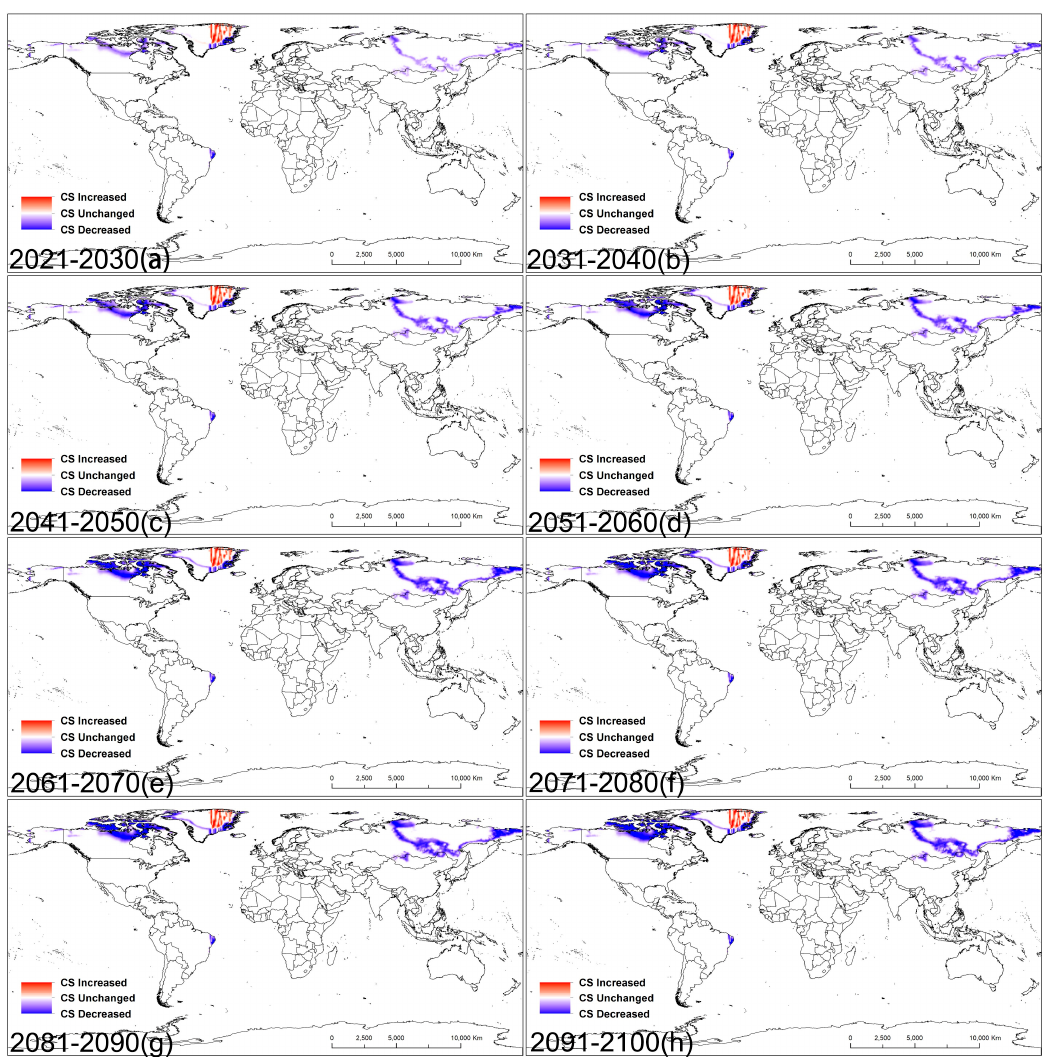
Figure B2. Climate change impacts on cold stress (CS) in D. ponderosae under the RCP4.5 scenario. ( a – h ) Global changes in CS in future decades (2021–2030, 2031–2040, 2041–2050, 2051–2060, 2061–2070, 2071–2080, 2081–2090, and 2091–2100) compared with historical conditions (1987–2016). The intensity of the color in different regions reflects the sensitivity to climate change (red, white and blue represents CS increased, unchanged and decreased, respectively).